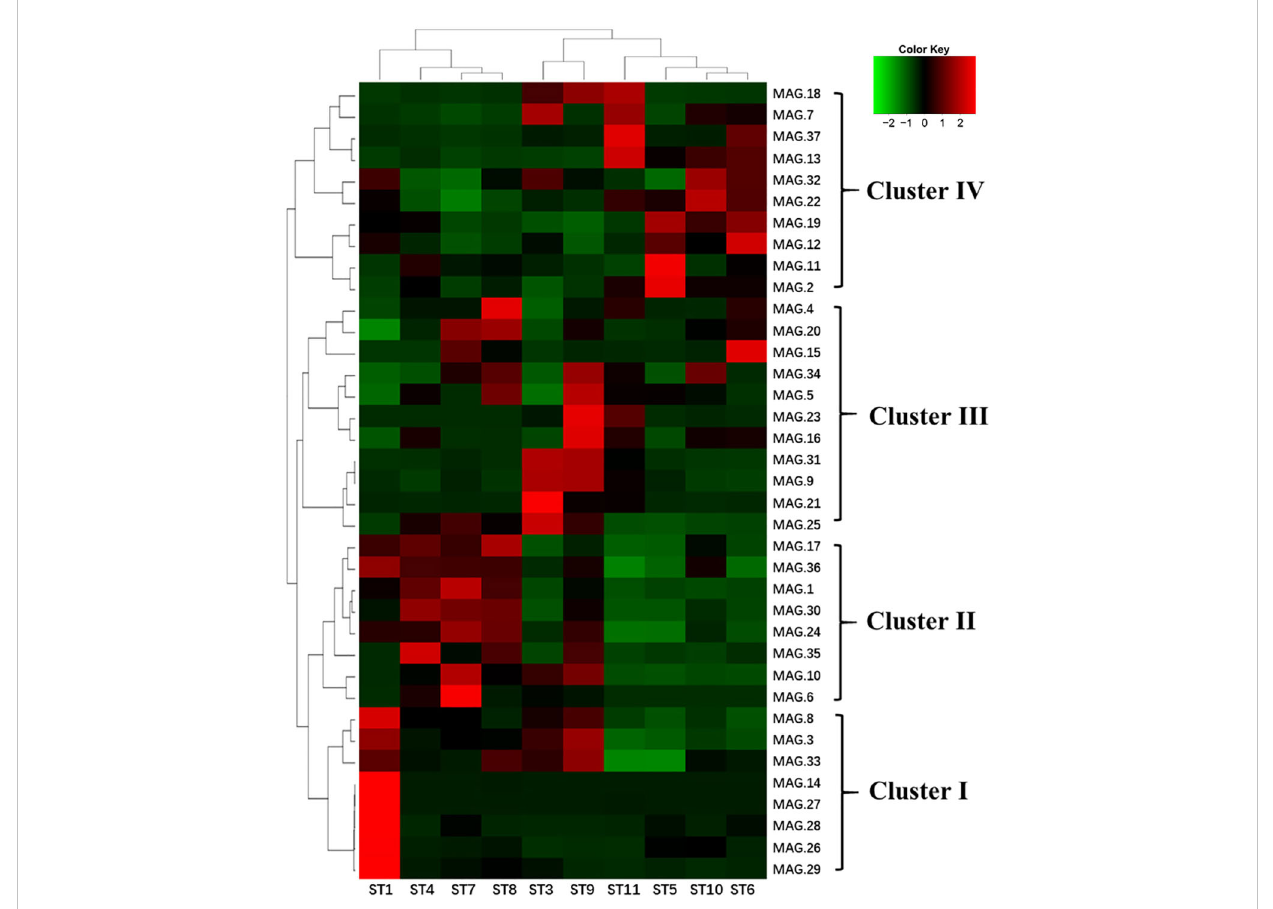
FIGURE 6 Heat map of the abundance analysis of MAGs of ten sampling points in the NWPO surface layer during the summer cruise (red indicates the higher relative abundance, while green indicates the lower relative